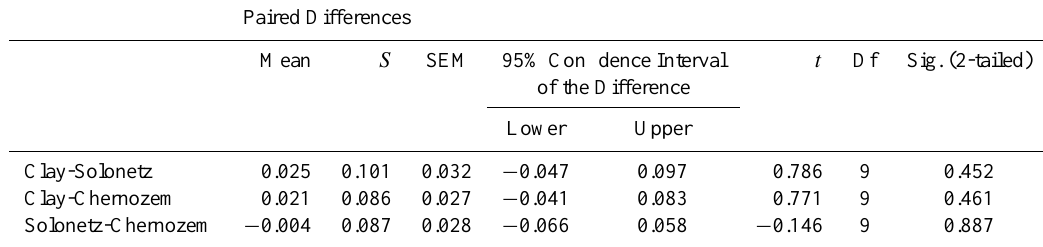
Table 4. Student-t-test for the Hurst exponents of three compared soils. Paired Differences Mean S SEM 95% Confidence Interval Df Sig. (2-tailed) of the Difference Lower Upper Clay-Solonetz 0.025